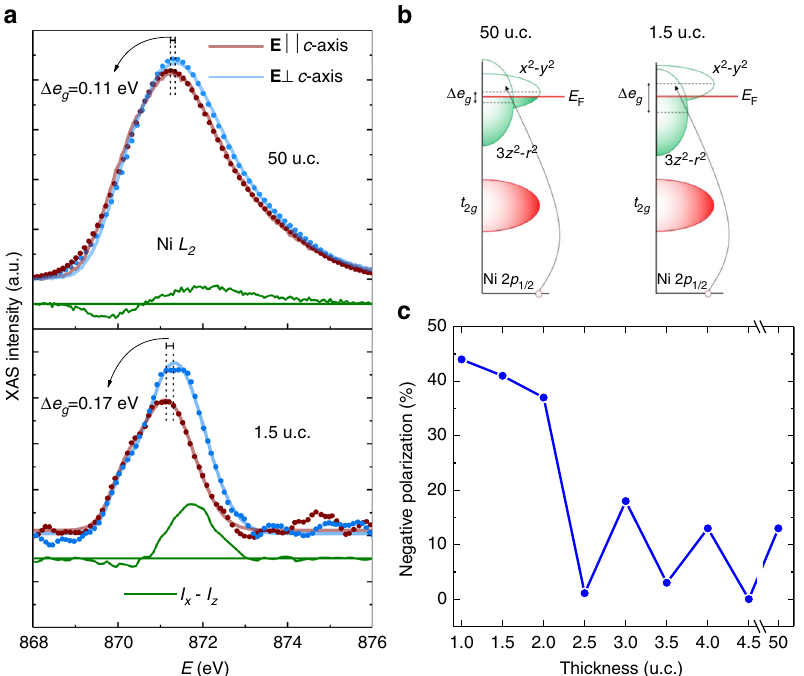
Fig. 4 Orbital polarization in the LaNiO 3 fi lms. a XAS spectra at Ni L 2 -edge for E ⊥ c (blue) and E ∥ c (red) polarizations and X-ray linear dichroism for a 50 u.c. and a 1.5 u.c LaNiO 3 fi lms. Solid lines show the Gaussian fi t. b Schematic of the 3 d orbitals for the 50 u.c. and 1.5 u.c LaNiO 3 fi lms. E F denotes the Fermi energy. c Magnitude of the negative d -orbital polarization vs. fi lm